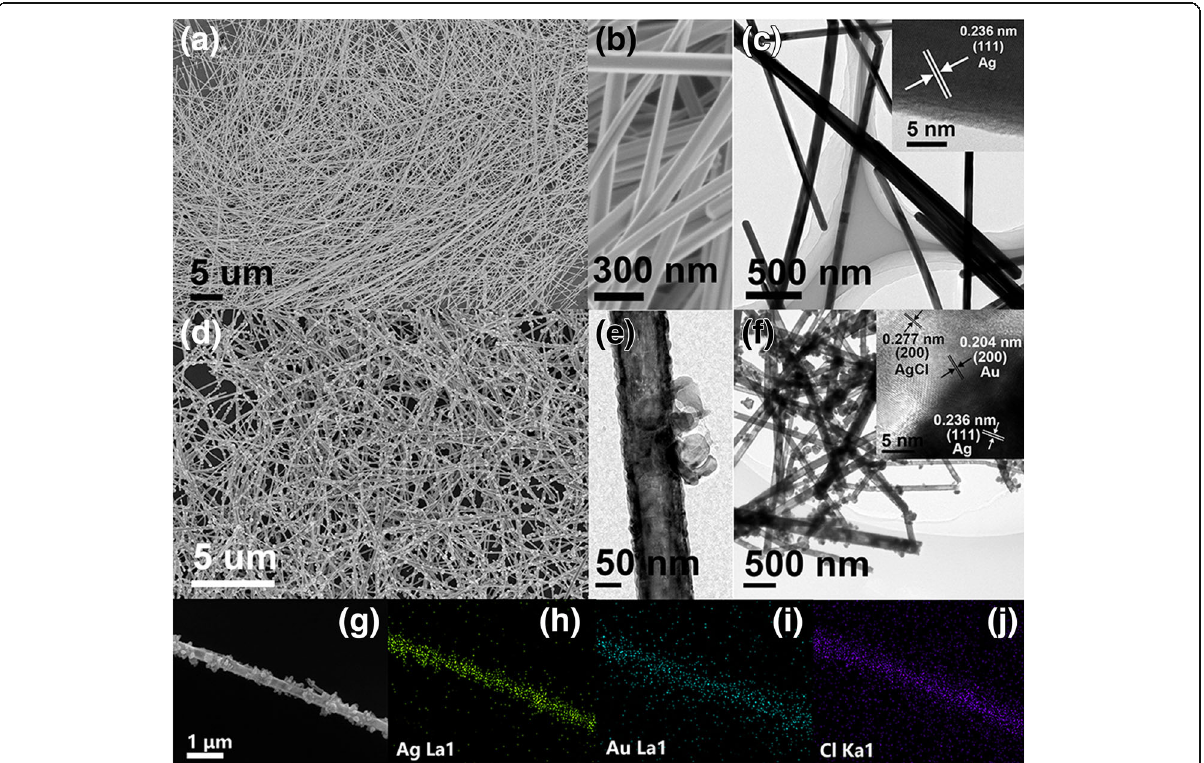
Fig. 2 a SEM images of Ag NWs. b The corresponding magnified SEM image. c TEM image of Ag NWs (the inset is HRTEM image of Ag NWs). d SEM image of Ag/Au/AgCl hollow heterostructures (S1). e The enlarged TEM image of a single Ag/Au/AgCl hollow NWs. f TEM image of Ag/Au/AgCl hollow heterostructures (the inset is the HRTEM image of Ag/Au/AgCl hollow heterostructures). g SEM image of a single Ag/Au/AgCl NWs. h – j The corresponding EDX mapping of Ag, Au, and Cl